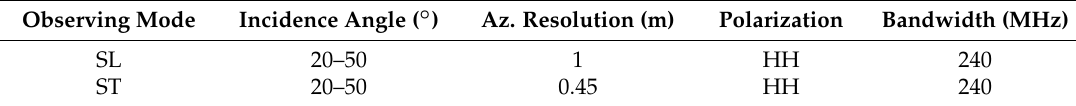
Table 1. Some parameters of Gaofen-3 (GF-3)’s sliding spotlight (SL) and staring spotlight (ST) modes.